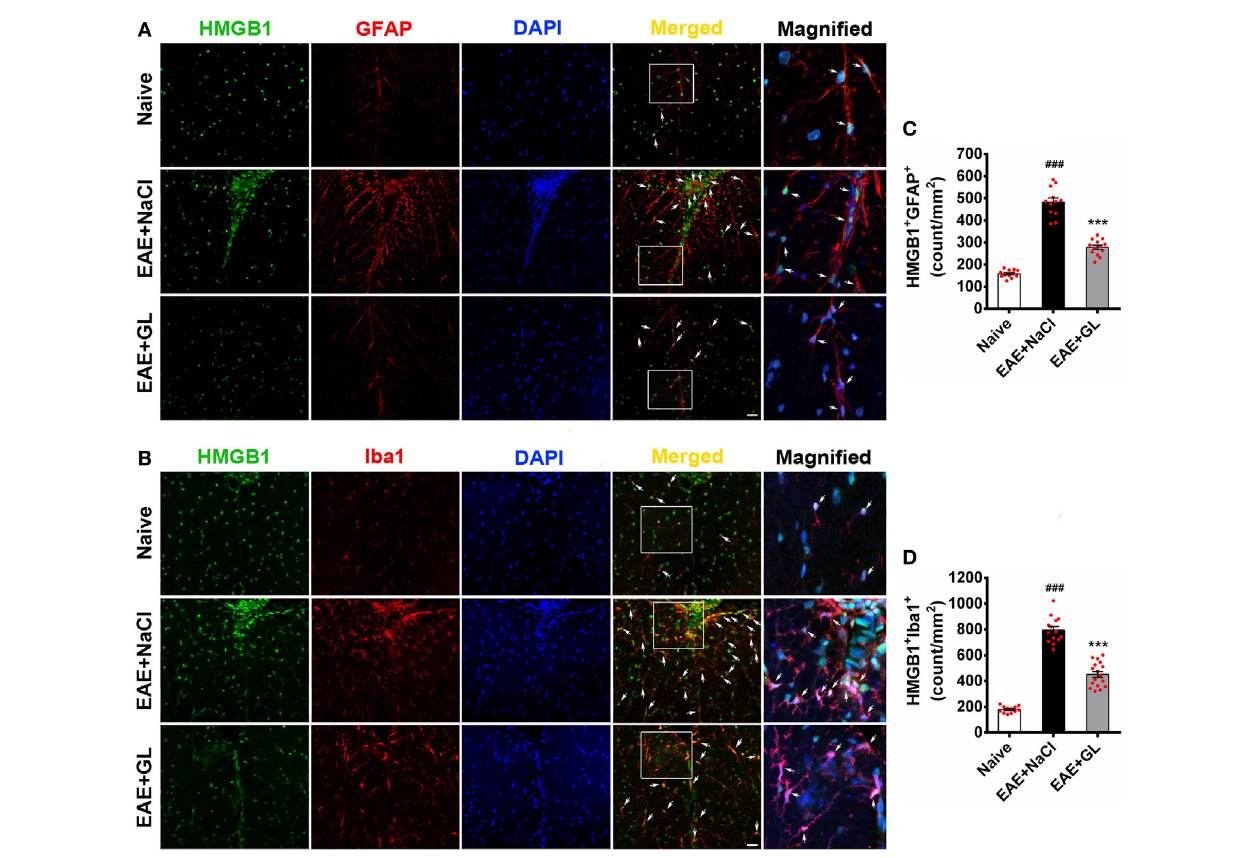
FigUre 5 | The number of high-mobility group box 1 (HMGB1)-expressing astrocytes and microglia in the thoracic spinal cord of experimental autoimmune encephalomyelitis (EAE) mice treated with glycyrrhizin (GL). HMGB1 was labeled with green fluorescence [glial fibrillary acidic protein (GFAP)] and Iba1 was labeled with red color, respectively. Nuclei were stained with DAPI in blue. (a) The expression of HMGB1 and GFAP in the white matter (WM) following confocal microscopy is indicated by white arrows. White boxes in the merged images are magnified regions. Arrows indicate HMGB1 + GFAP + cells. Scale bar: 20 µm. (B) The expression of HMGB1 and Iba1 in WM following confocal microscopy is indicated by white arrows. White boxes in the merged images are magnified regions. Arrows indicate HMGB1 + Iba1 + cells. Scale bar: 20 µm. (c,D) The number of HMGB1 + GFAP + and HMGB1 + Iba1 + cells was significantly different in GL-treated and NaCl-treated EAE mice. Data are expressed as the mean ± SEM, n = 4 animals in each experimental group. ### P < 0.001 vs naive group; *** P < 0.001 vs EAE + NaCl group, using one-way ANOVA followed by Bonferroni’s